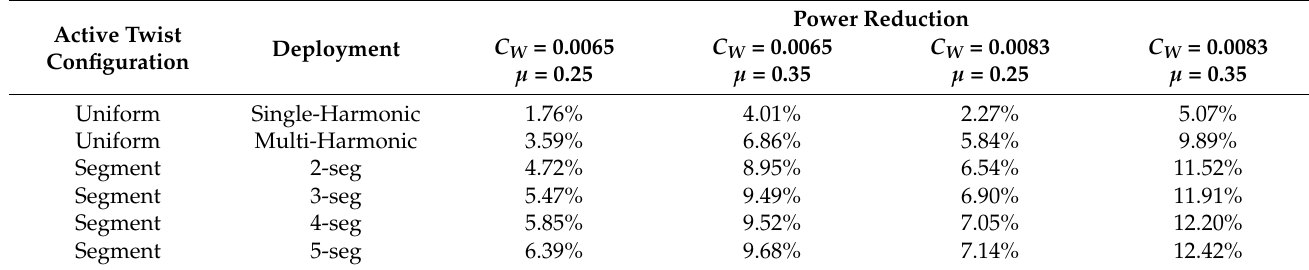
Table 4. Rotor power reductions for the selected flight